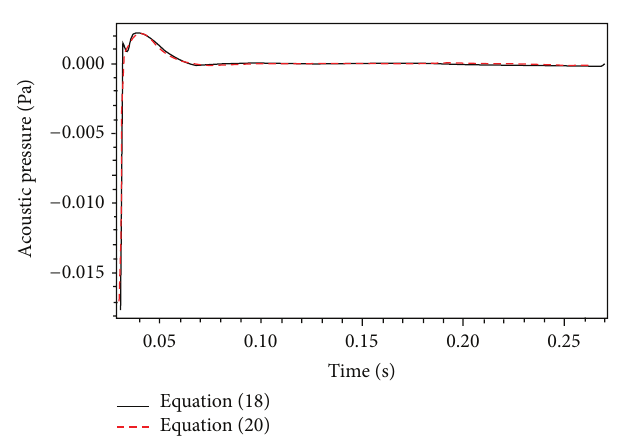
Figure 5: Comparison between two methods for calculating acoustic